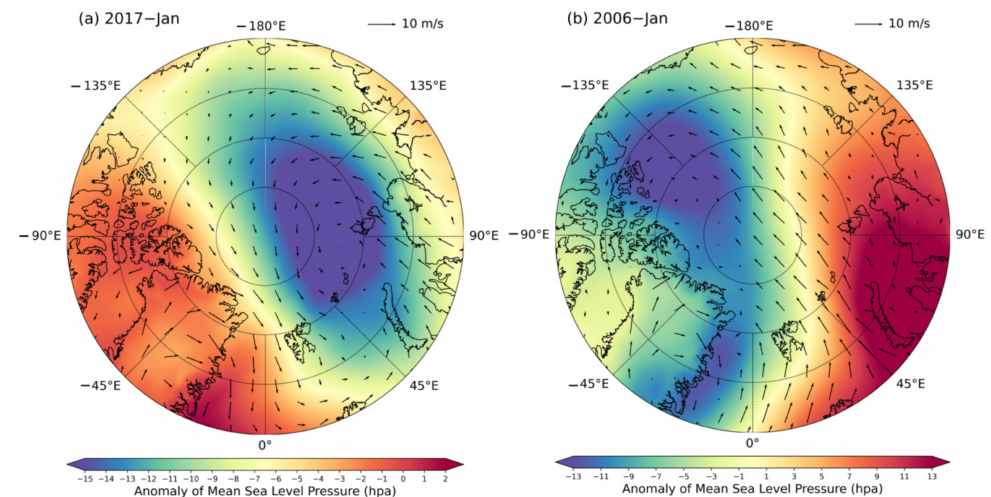
Figure 11. ERA5 SLP anomaly and 10 m wind fields of ( a ) 2017 January (positive DA) and ( b ) 2006 January (negative DA).